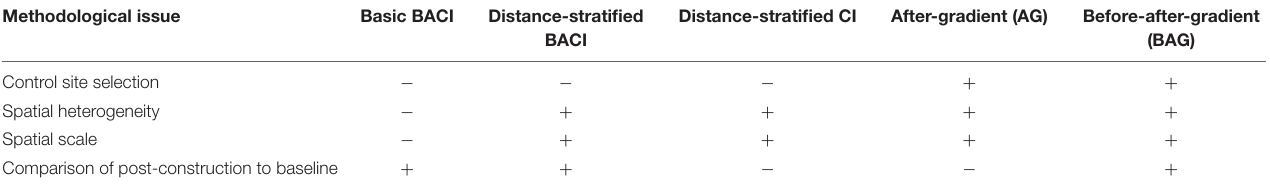
TABLE 1 | Comparison of pros and cons of the simple BACI design with enhanced sampling methods that include distanced-based sampling. Methodological issue Basic BACI Distance-stratified Distance-stratified CI After-gradient (AG) Before-after-gradient BACI